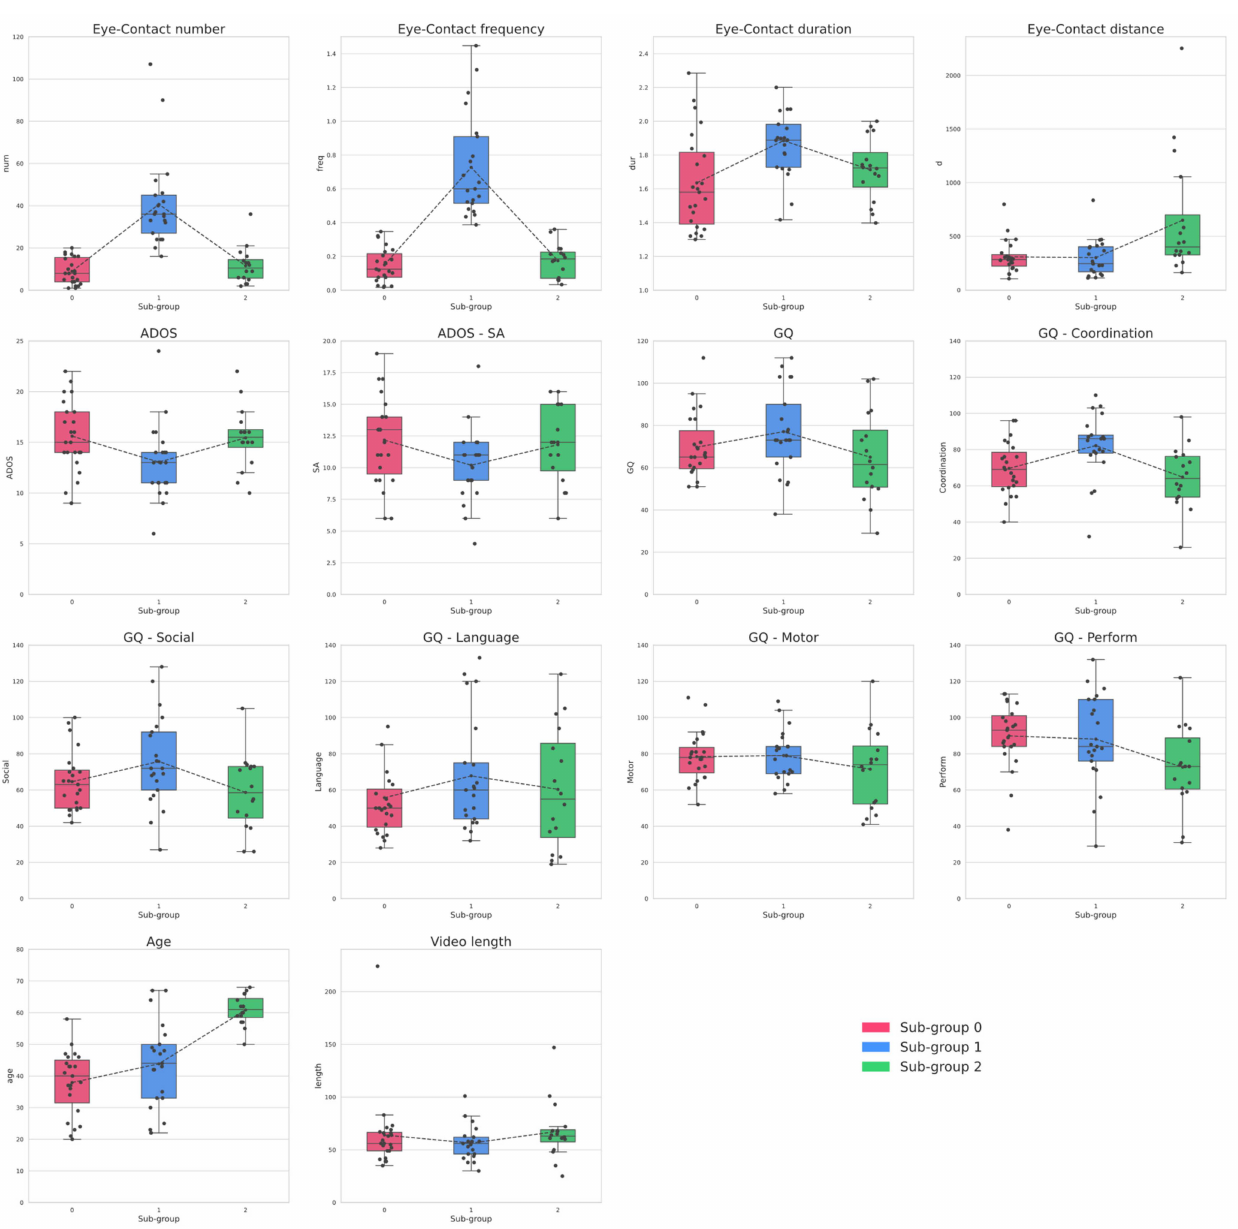
Figure 3. Boxplots of each dependent and independent variable for resulting sub-groups; num: eye-contact periods total number; freq: eye-contact periods frequency (N/min); dur: eye-contact periods average duration (s); d: average distance of children’s gaze vectors from therapists’ headboxes during interaction (px); age: children’s age at first assessment (months); length: video total duration